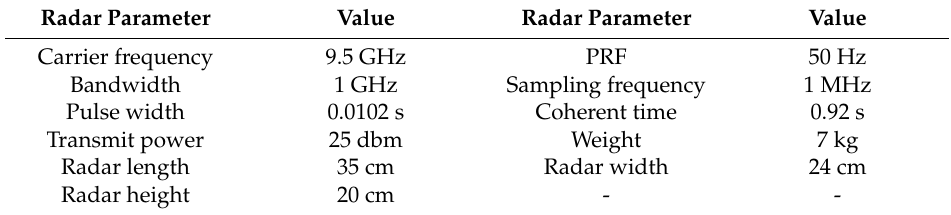
Figure 10. Experimental data processing results. ( a ) The experimental scene; ( b ) the FMCW radar system; ( c ) the radar antennas; ( d ) moving trajectory of the UAV; ( e ) parameter estimation result of FD-SoPD; ( f ) the coherent integration result of FD-SoPD; ( g ) the coherent integration result of the MTD; ( h ) the coherent integration result of the SCIFT. Table 4. Frequency-modulated continuous-wave (FMCW) radar parameters. Table 5. Comparisons of experimental parameter estimation results.